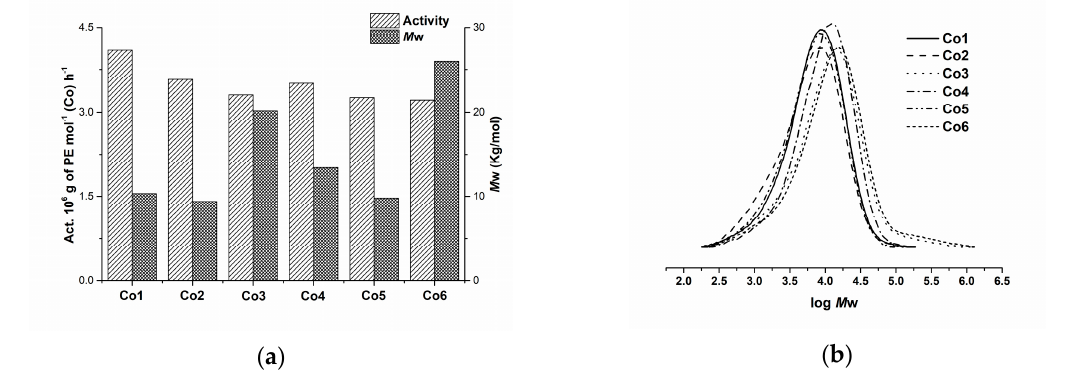
Figure 3. ( a ) Polymerization activity and M w of PE by Co1 ‐ Co6/ MAO; ( b ) GPC curves of PE obtained by Co1 ‐ Co6/ MAO (runs 9 and 17–21, Table 2).